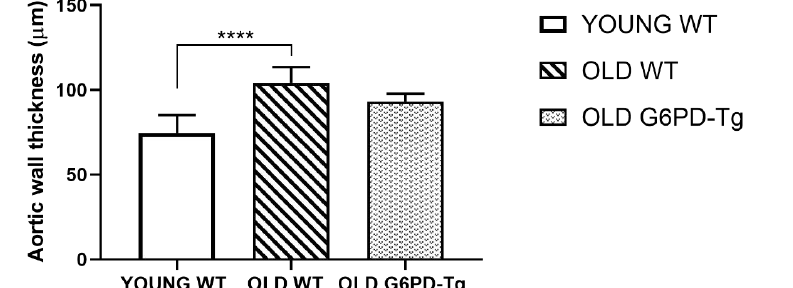
Figure 5. Aortic wall thickness for all groups studied. Results are means ± SD ( n = 8 – 10 per group). **** p < 0.0001. **** p < 0.0001.